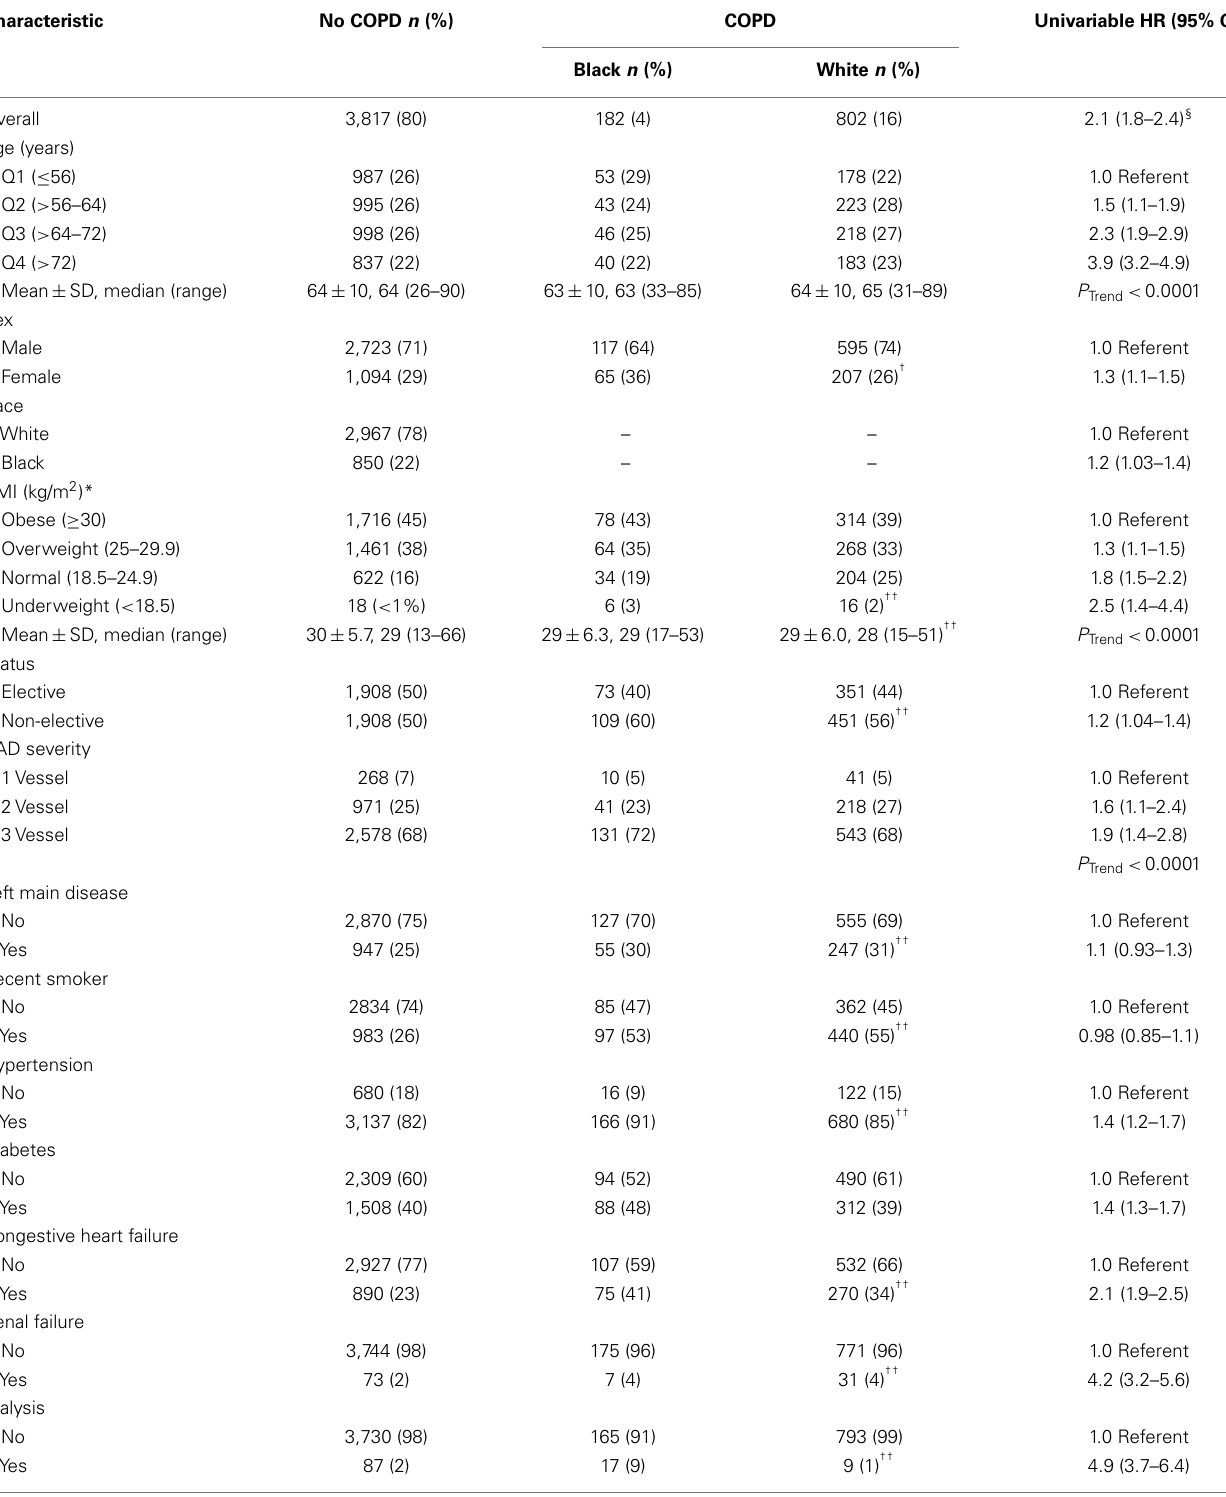
Table 1 | Patients characteristics and univariable survival after CABG ( N =